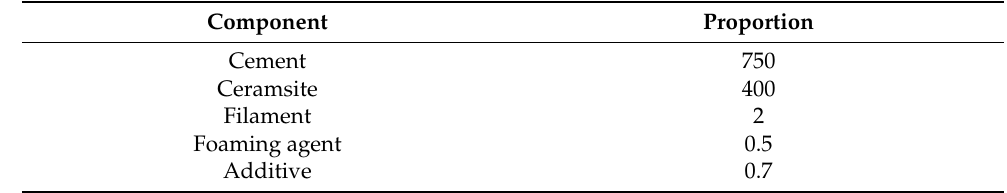
Table 1. The proportions of the ceramsite concrete mixture (kg/m 3